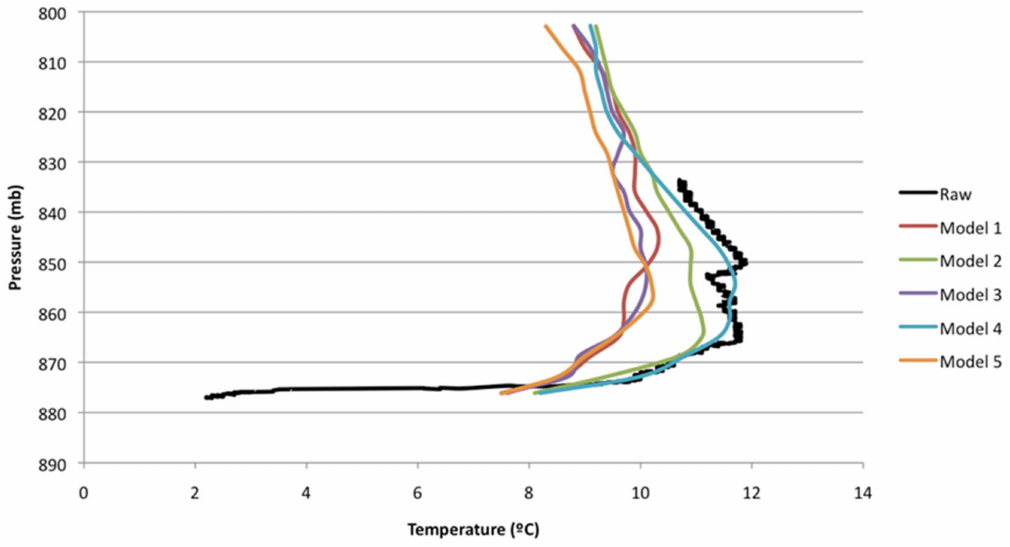
Figure 19. Model upper-air temperature profile ( ◦ C) shown by pressure level (hPa) for different